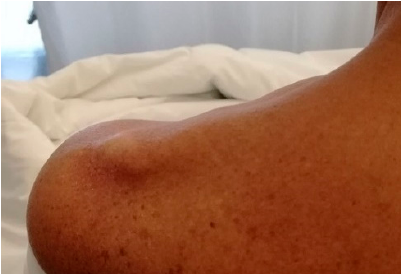
Figure 2. A clinical photograph of a patient with suprascapular nerve compression shows the resultant atrophy in the supraspinatus fossa.